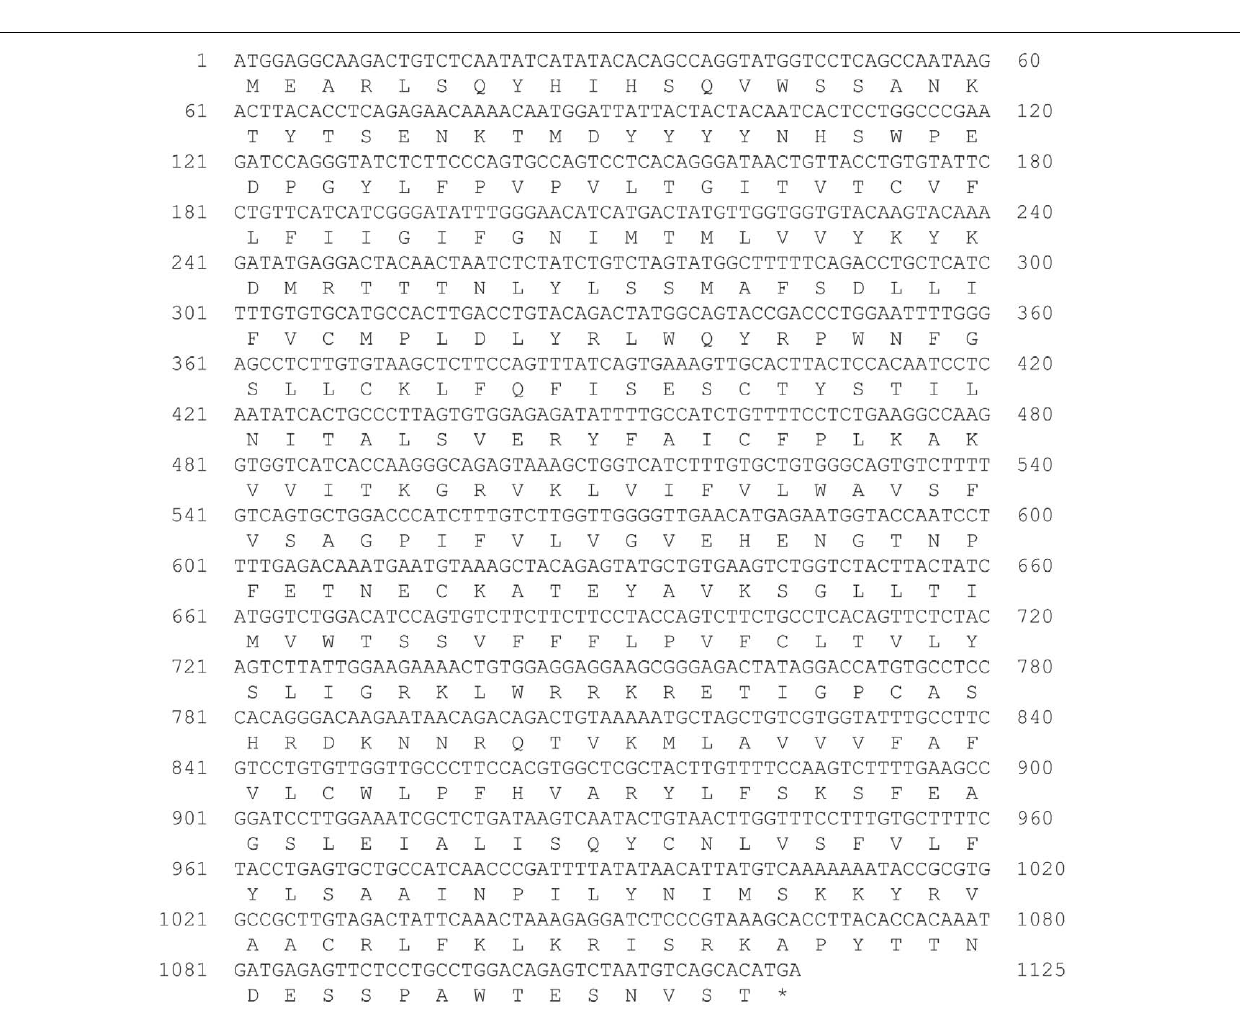
receptors in bullfrog and tree frog were functional ghrelin receptor